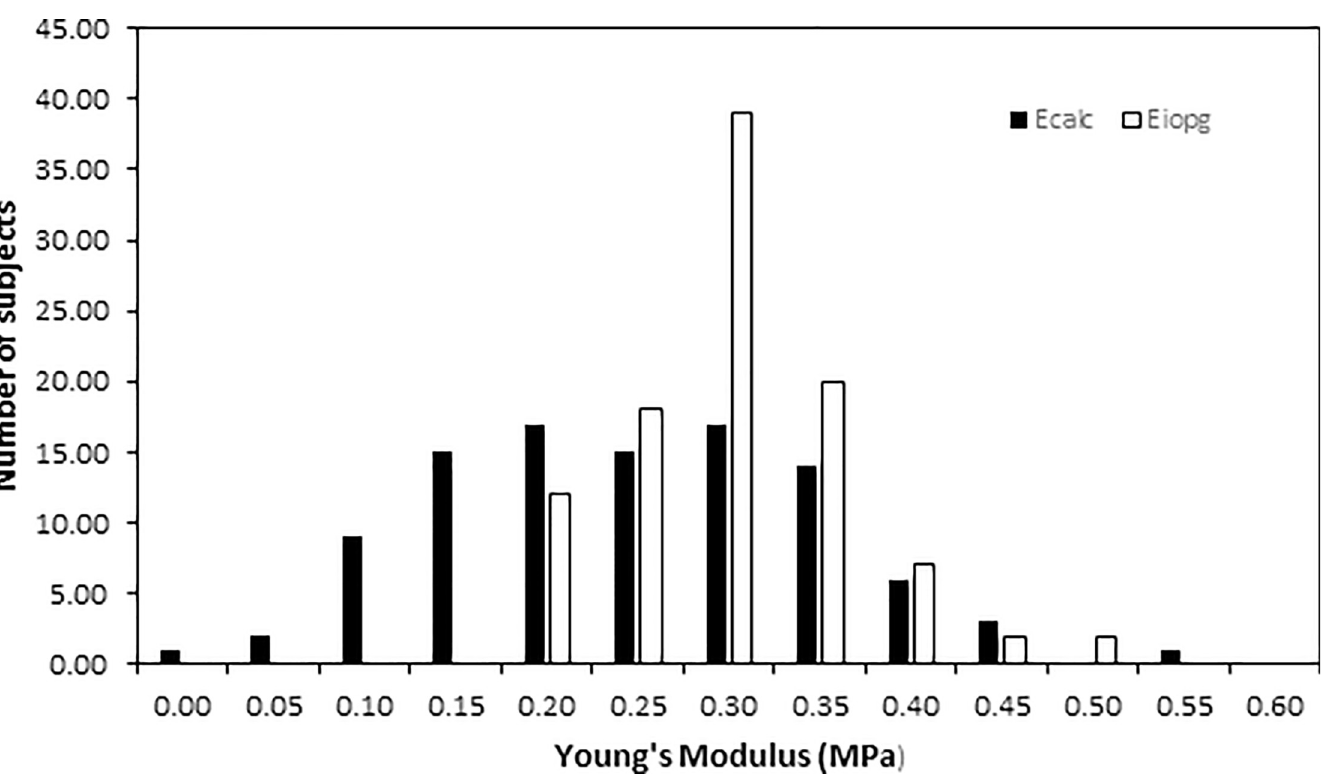
Fig 1. Distribution of Young’s modulus in 100 young healthy eyes as calculated using the Orssengo and Pye formula and Goldmann tonometry results only (Eiopg) or Goldmann and Pascal DCT results combined (Ecalc).